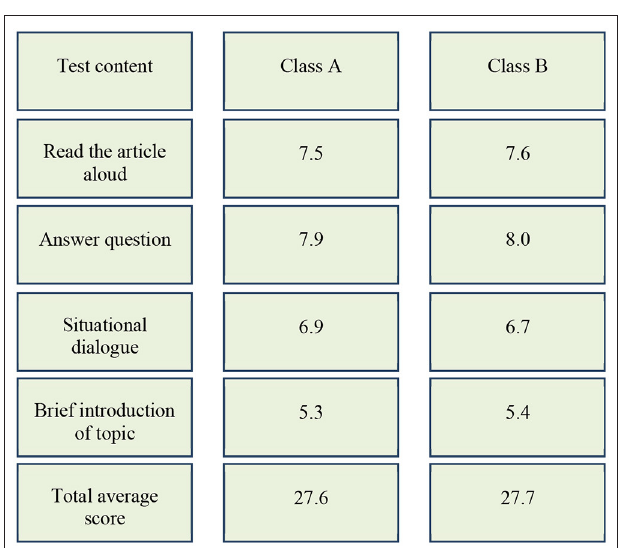
FIGURE 6 | Comparison of pre-test scores of students in classes A and B.